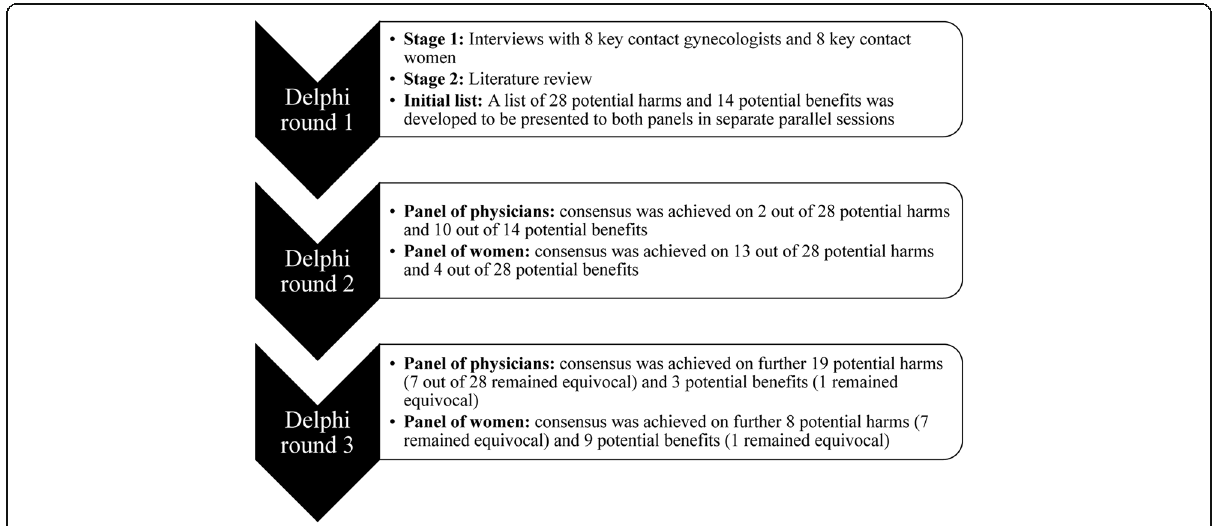
Fig. 1 Details of the Delphi iteration process